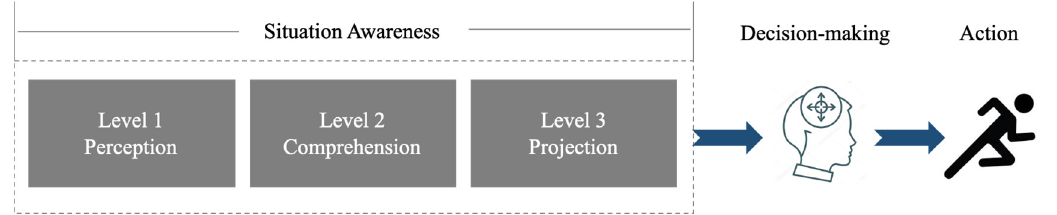
Figure 2. A simple version of Endsley’s model: situation awareness (SA), decision-making, and action (Own Creation).